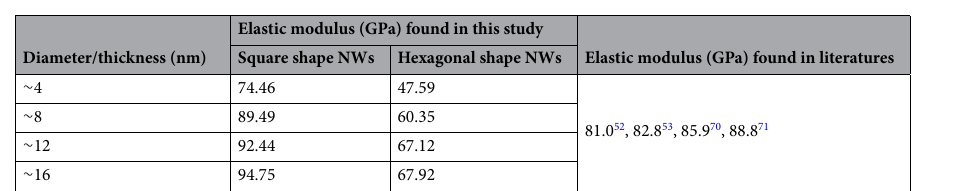
Table 1. Calculated elastic modulus of [111]-oriented zinc-blende ZnSe NWs at 300 K.